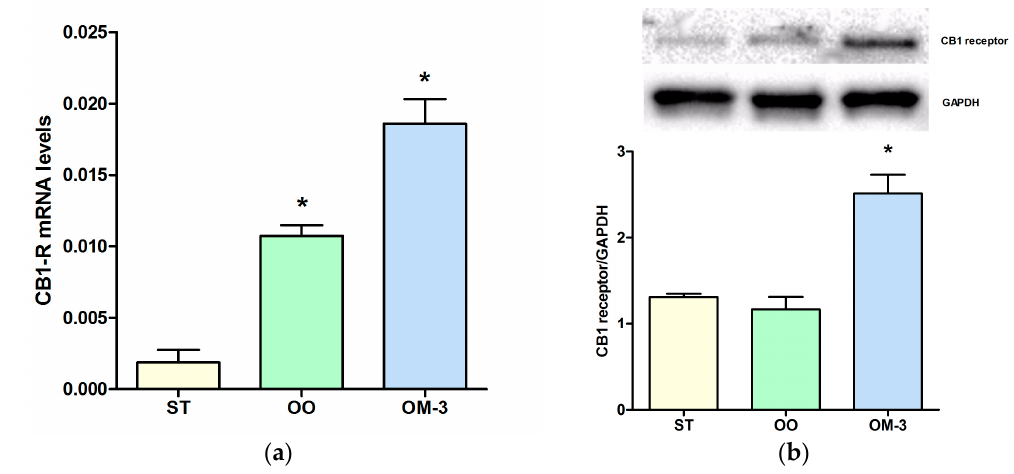
Figure 2. Cannabinoid receptor-1 ( CB1) receptor gene expression levels (mean ± SE) in intestinal tissue of 10 Apc Min/+ mice for each group ( a ). Data expressed as molecule numbers of CB1 receptor gene mRNA/molecule numbers of β -actin mRNA ( b ) Western blotting analysis of expression of the CB1 receptor protein in intestinal tissue of Apc Min/+ mice. ST = control group; OO = olive oil group; OM-3 = ω -3 PUFAs group. * p < 0.05 (ANOVA and Dunnett’s multiple comparison test, each experimental group vs. the control (ST) group).